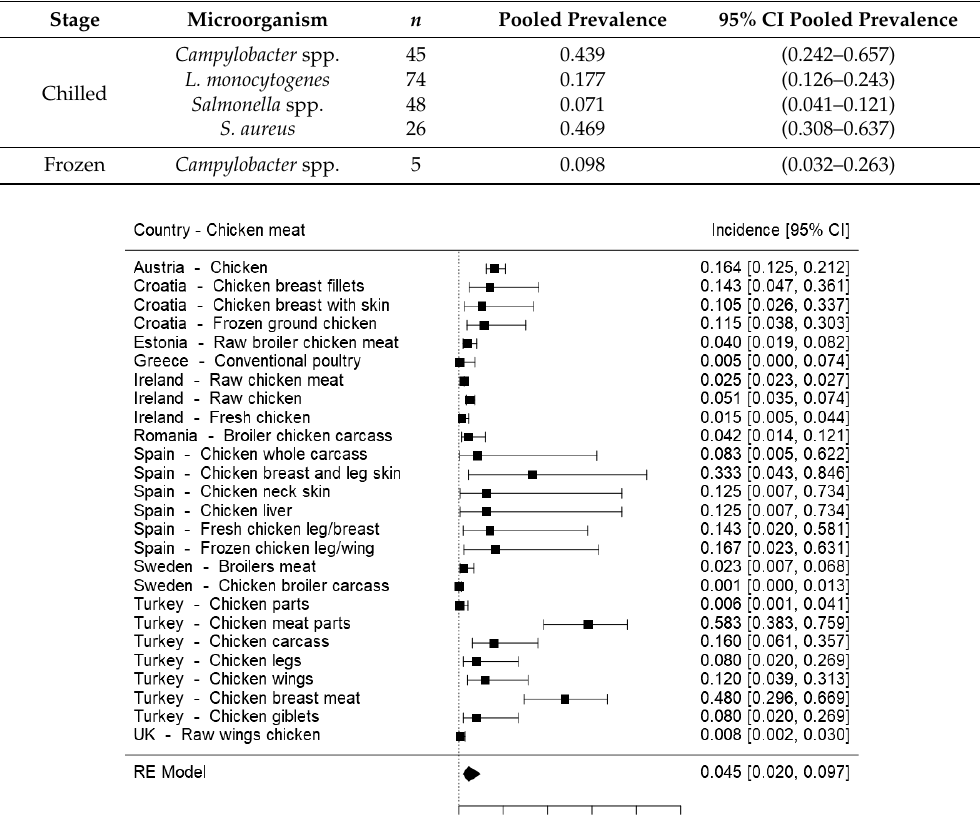
Table 4. Meta-analysis of the incidence of pathogens in poultry meat by cold preservation type.